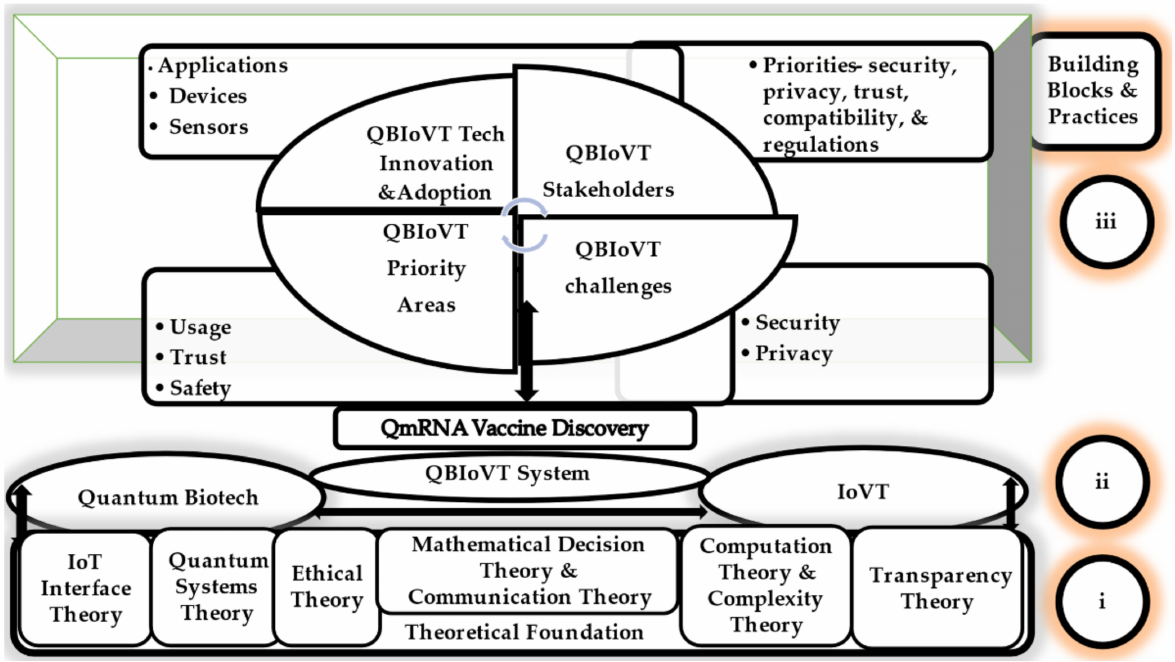
Figure 11. A novel theoretical